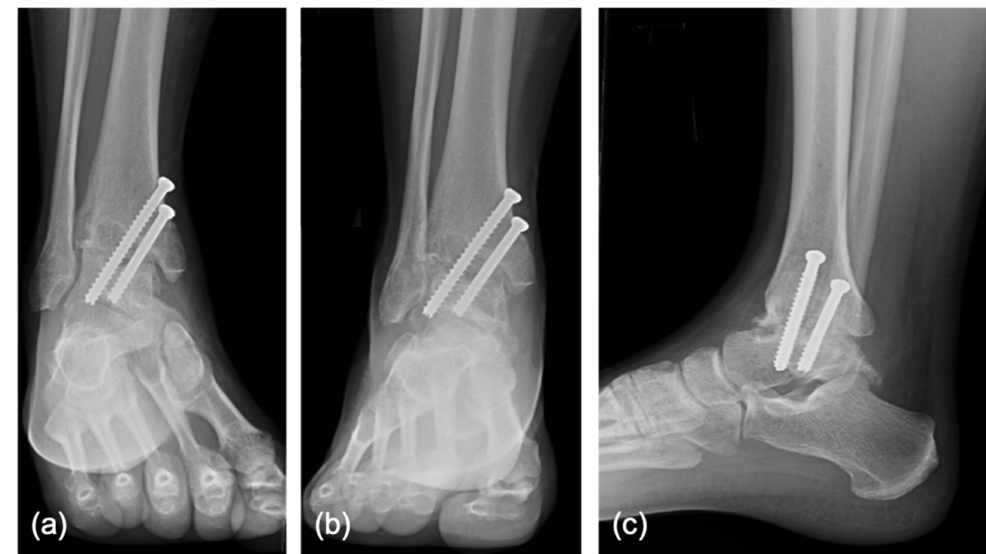
Figure 3. Immediate postoperative radiographs, including non-weight-bearing mortise ( a ), anterior– posterior ( b ), and lateral ( c ) views, of a 26-year-old male with hemophilia who underwent arthroscopic tibiotalar arthrodesis of the right ankle with the supplementation of demineralized bone